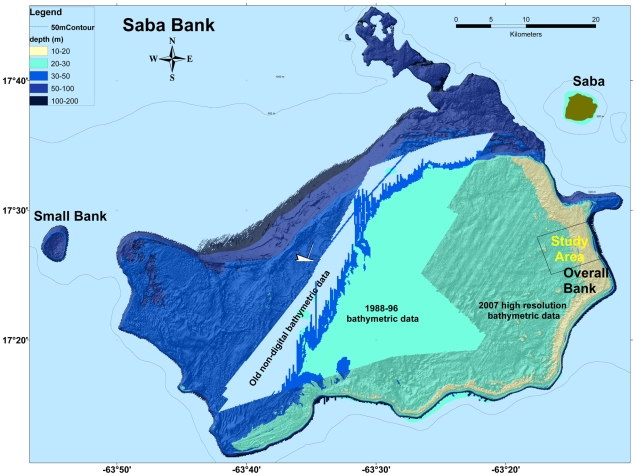
Bathymetric map of Saba Bank.The Saba Bank map was assembled in ArcGIS using available datasets for bathymetry of Saba Bank. Sampling was conducted on a region of Saba Bank named Overall Bank as shown (rectangle at right).